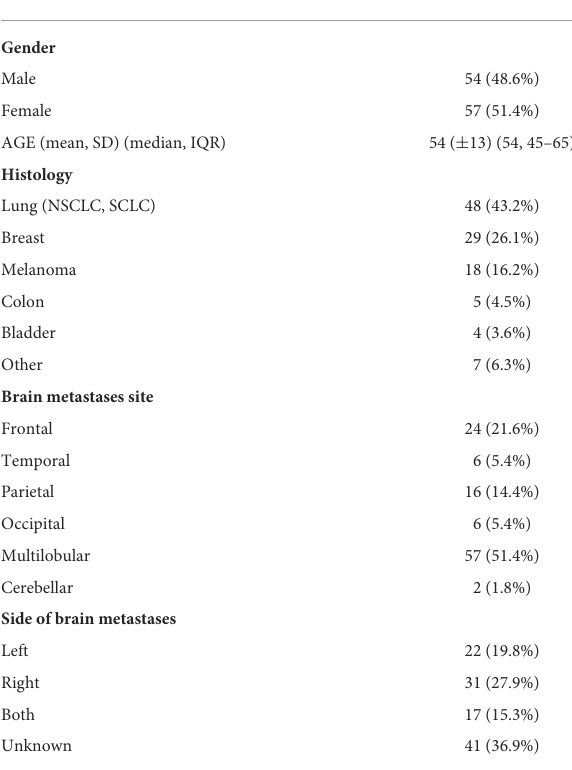
TABLE 1 Demographic and oncological variables in the whole population ( n = 111 patients) at the first neurological examination. Patient